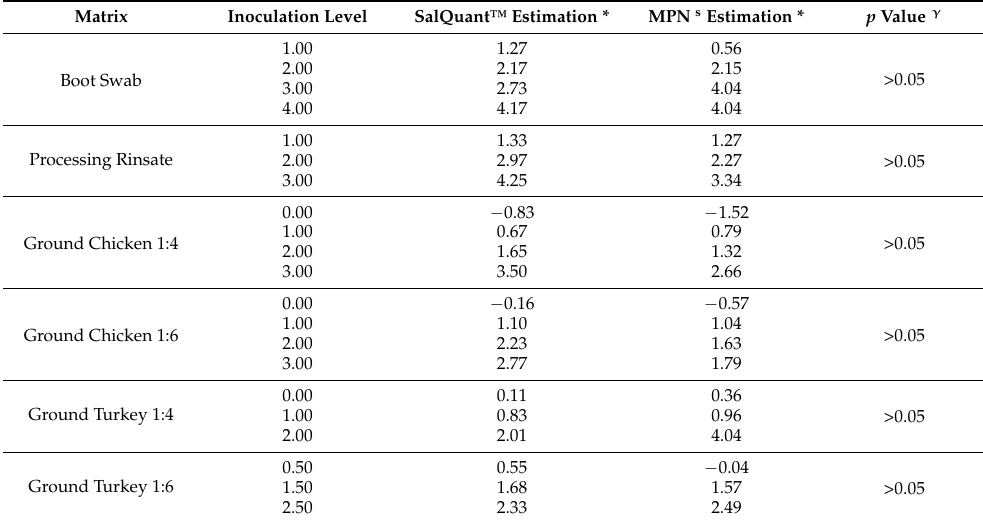
Table 2. SalQuant ® Curve Estimations Compared to MPN